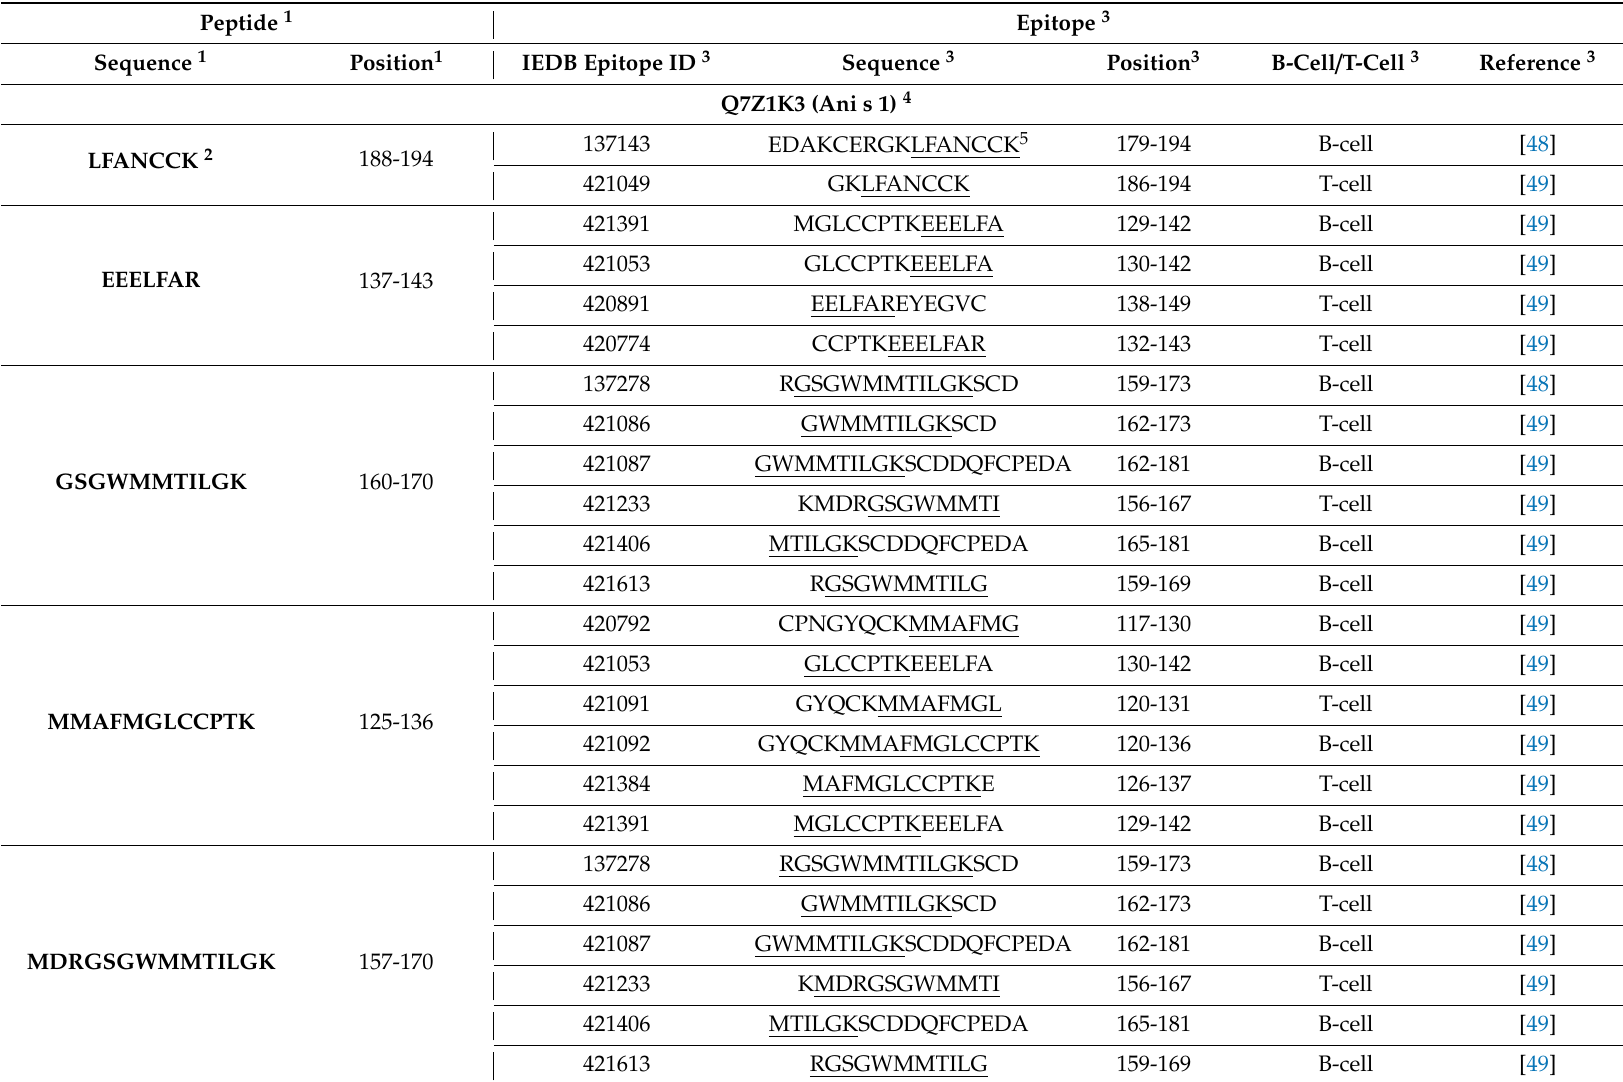
Table 4. List of known B-cell / T-cell epitopes that were bioinformatically identified in Ani s 1 and Ani s 5 peptides derived from the autoclaved antigen of A. simplex